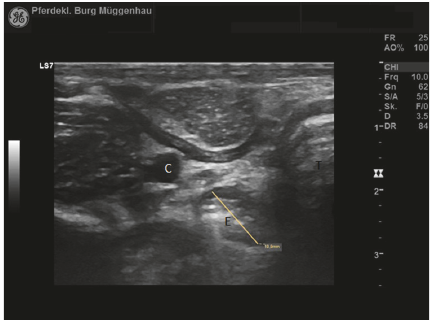
Figure 6: Ultrasound image of the stricture site at final follow-up examination. Diameter was measured at 10,9 mm. Left in the image isdorsal.C:carotidartery.E:esophagus.T:trachea(probefrequency 10 MHz, depth 3,5